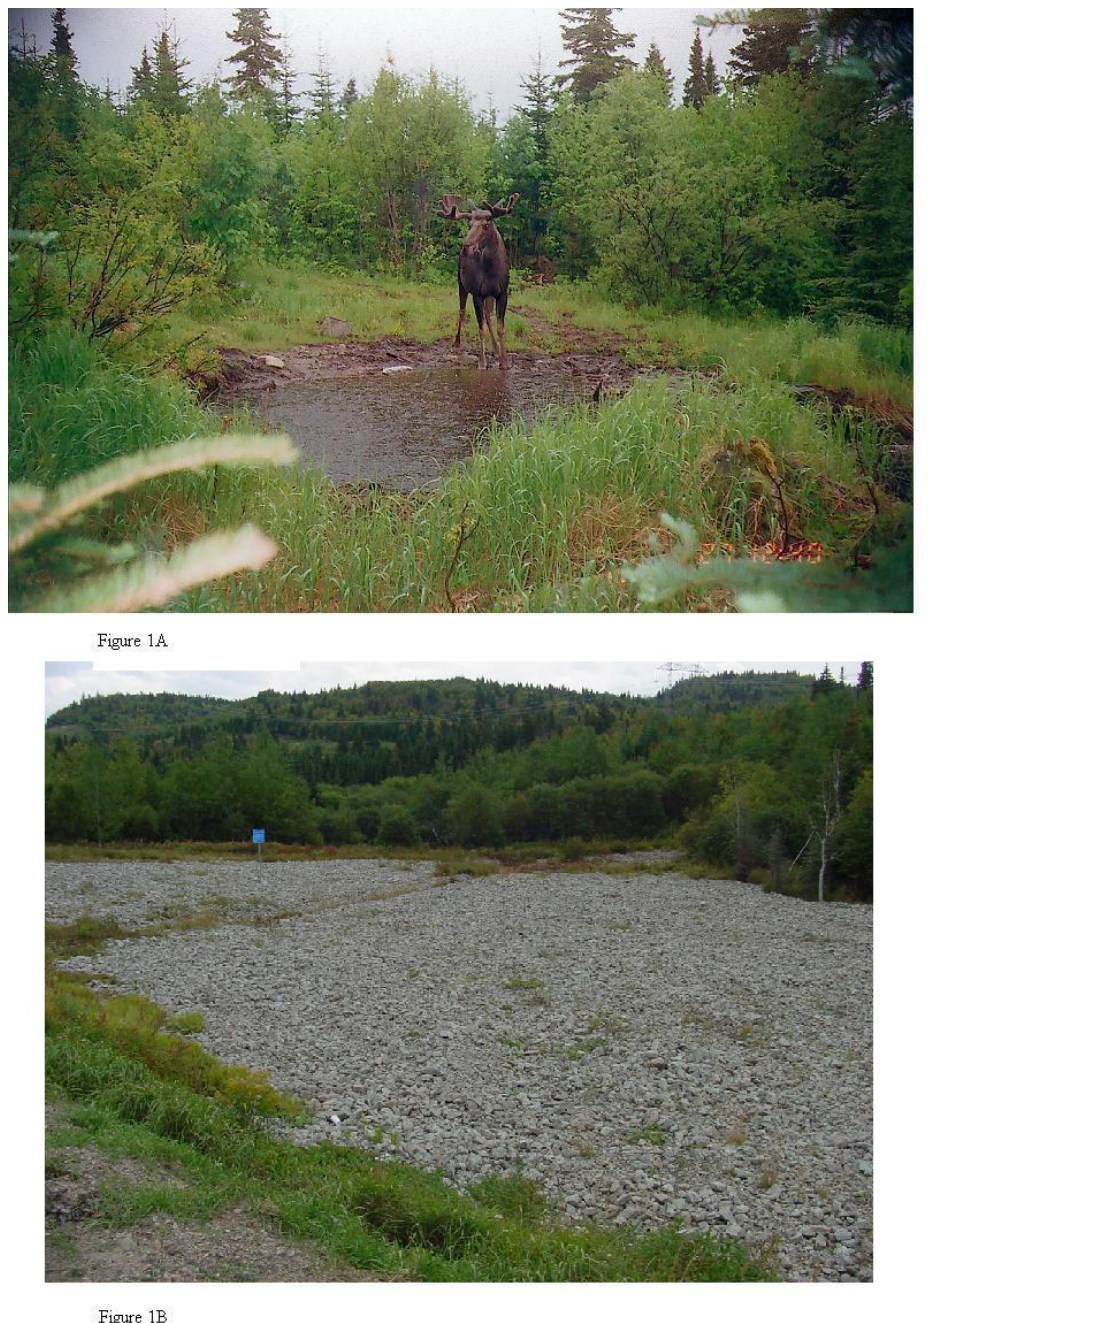
Fig. 1 . Salt pools near roads. (A) A moose at a roadside salt pool, B) a roadside salt pool after it has been drained and filled with rocks. (Photographs courtesy of M. Leblond, Université du Québec à